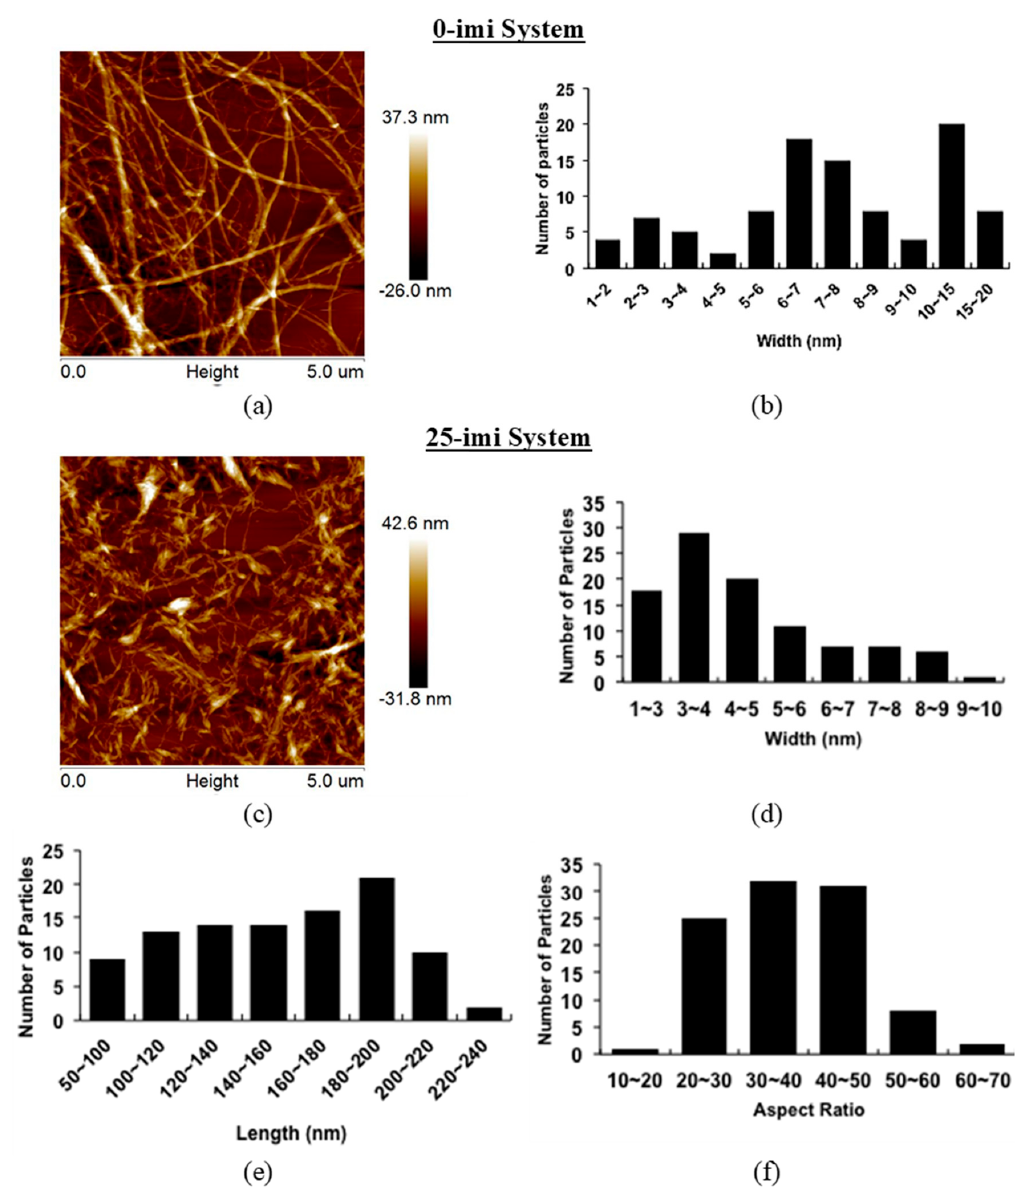
Figure 4. AFM height images and dimensional distributions evaluated from AFM images of CNFs obtained with pure imidazole (0-imi) system ( a , b ); and CNCs obtained with aqueous imidazole (25-imi) system ( c – f ).